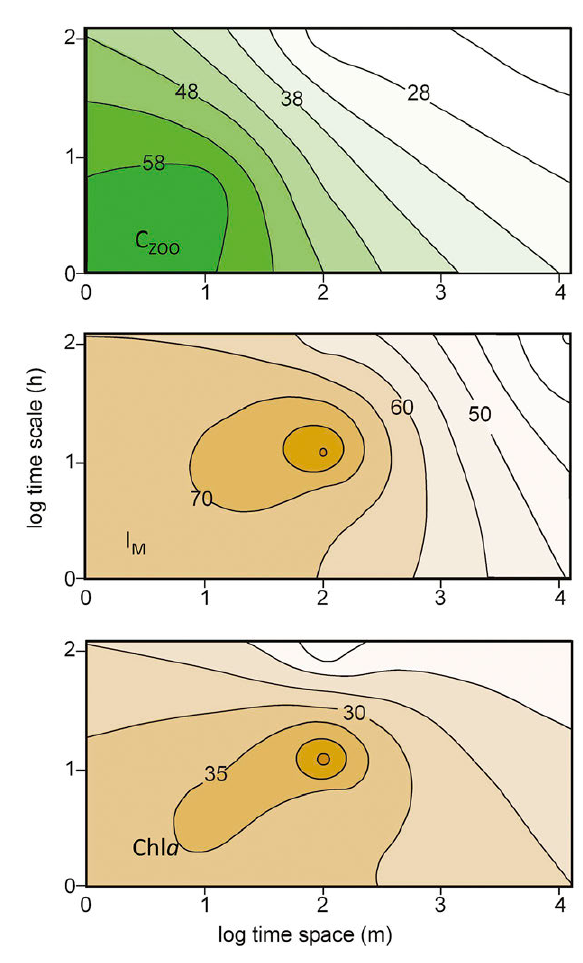
Fig. 7. – Contours of the variability (CV) of C the spatial and temporal scales considered in the study, from <10 (depths strata) to 10 4 m (between stations), and from <10 h (between successive daily hauls) to 10 2 h (between successive legs). Horizon- tal axis, log space scale (m); vertical axis, log time scale (h).